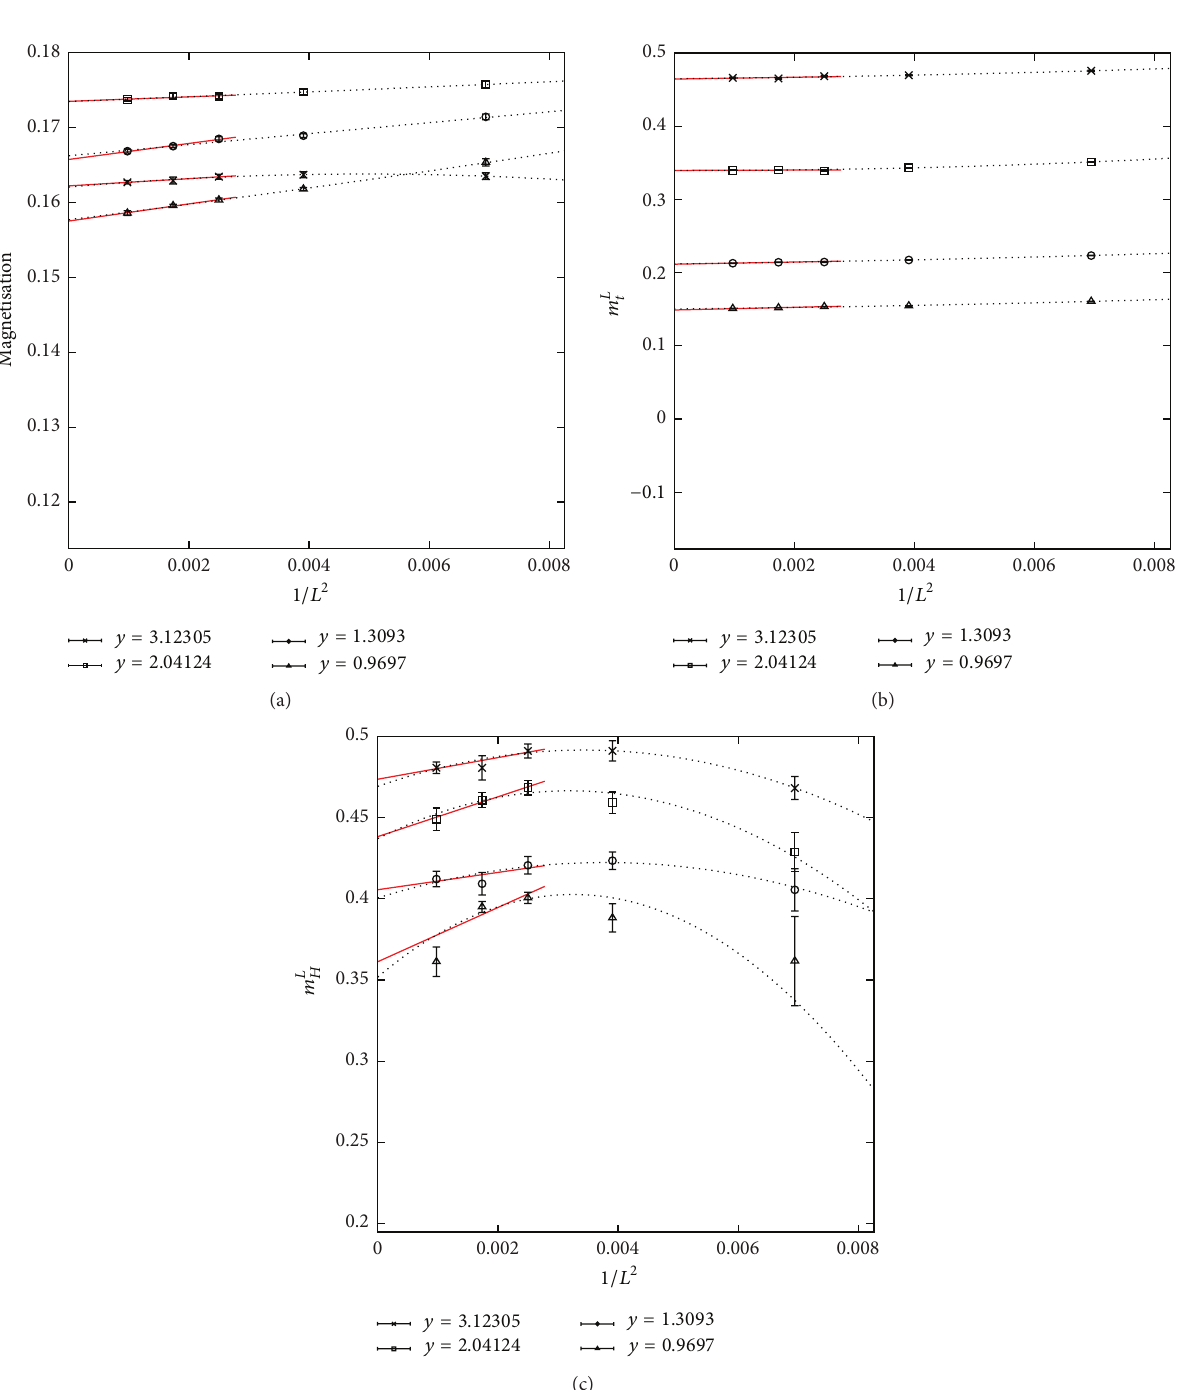
̂𝜆 , and fermion masses in the range 𝑚 𝑓 ≈ 200 − 700 GeV.